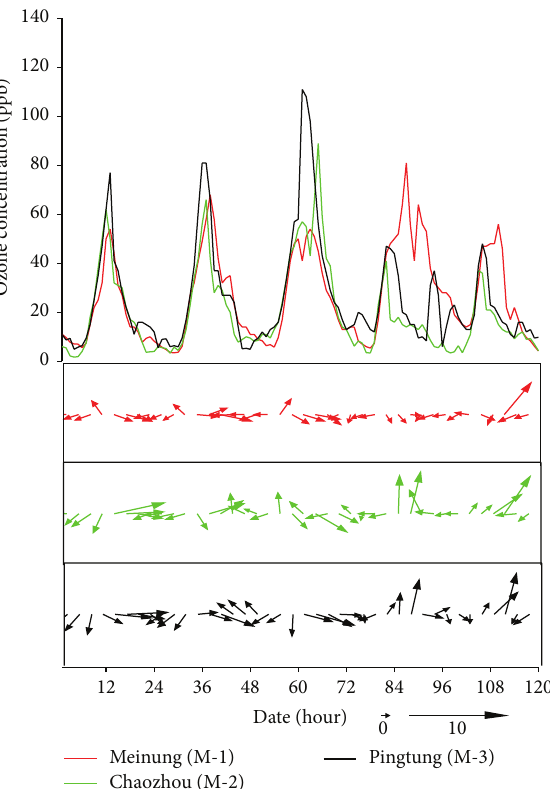
Figure 5: Observed O 3 concentrations and wind field for mountain group (M group) ambient air quality monitoring stations during June 28 and July 2,